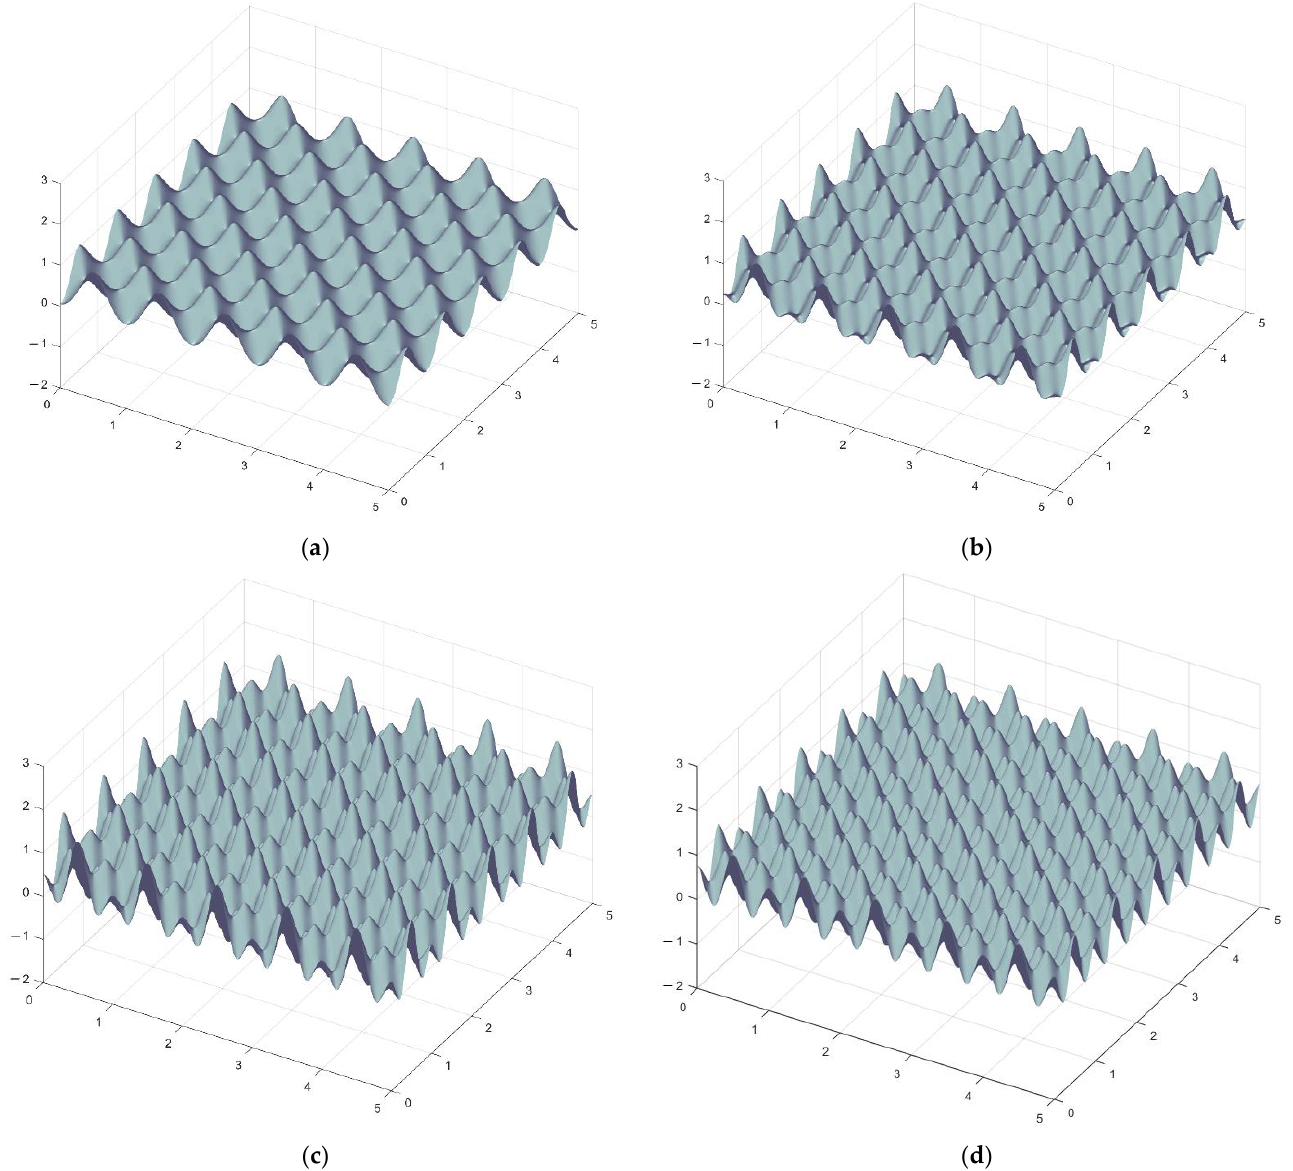
Figure 9. Substrate potential surfaces for different values of parameter 𝐵 : ( a ) 𝐵 = 0.1 , ( b ) 𝐵 = 0.5 , ( c ) 𝐵 = 1.0 , ( d ) 𝐵 = 2 .